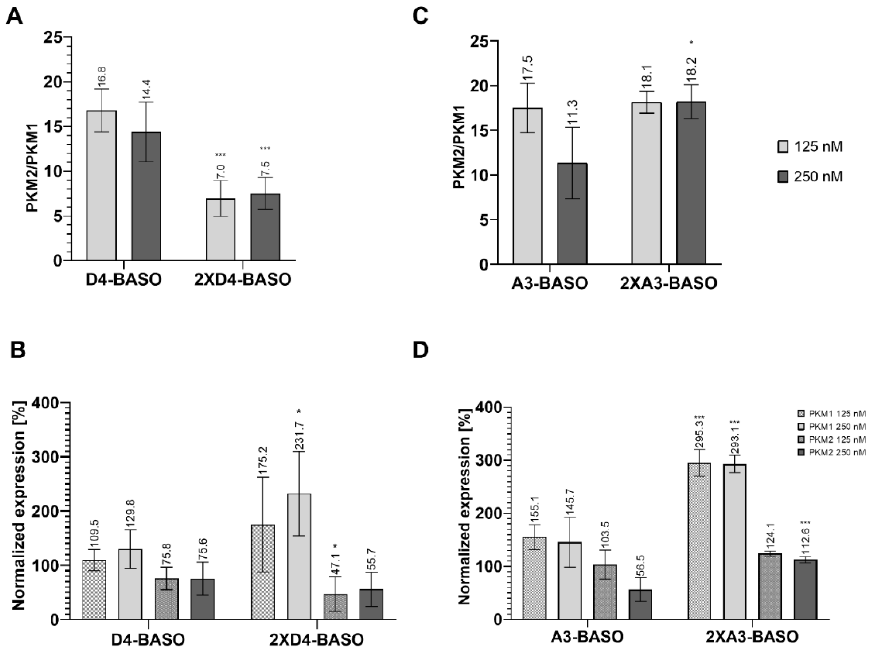
Figure 4. ( A ) The ratio of PKM2/PKM1 isoforms after transfection of D4-based linear and branched BASO. ( B ) The PKM1 and PKM2 isoforms normalized expression after transfection of D4-based linear and branched BASO. The normalized expression was calculated as a percentage of expression in non-transfected cells. ( C ) The ratio of PKM2/PKM1 isoforms after transfection of A3-based linear and branched BASO. ( D ) The PKM1 and PKM2 isoforms normalized expression after transfection of A3-based linear and branched BASO. The normalized expression was calculated as a percentage of expression in non-transfected cells. To obtain statistical significance, the branched BASOs results were compared with linear version of BASO. * indicates statistical significance at a level of p < 0.05; *** indicates statistical significance at a level of p < 0.01.